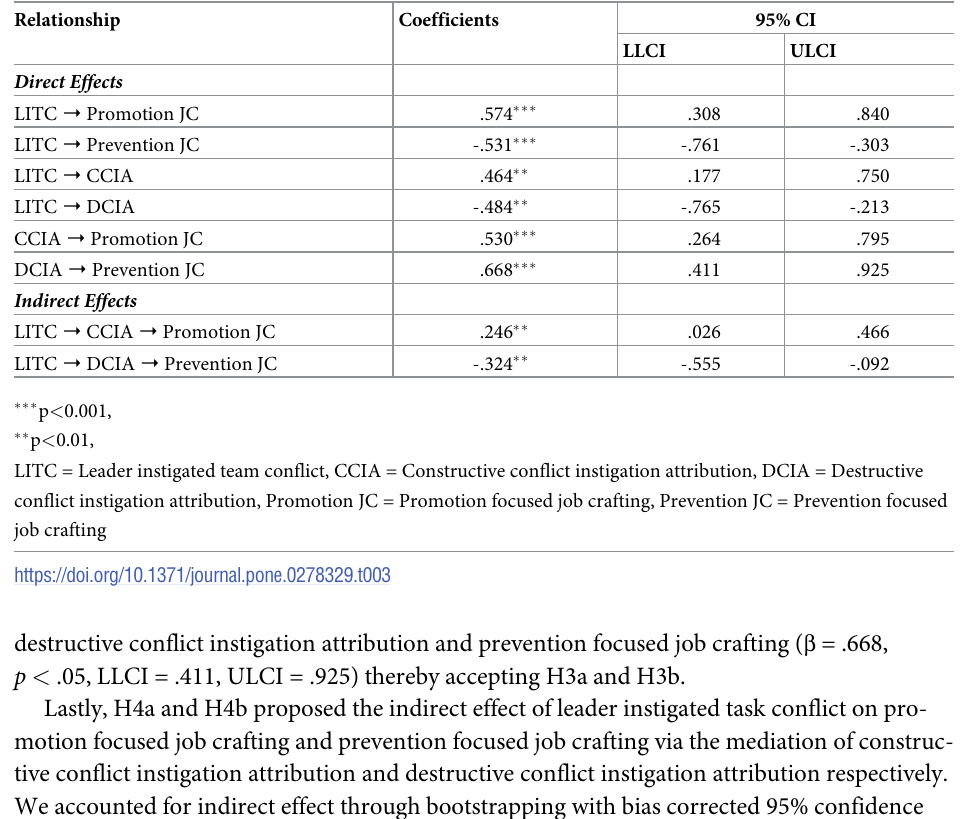
Table 3. Path coefficients in the baseline